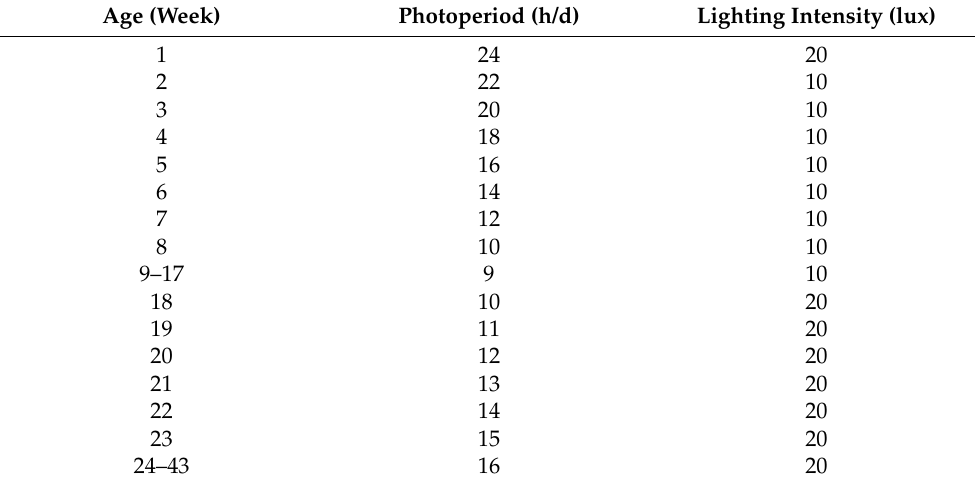
Table 2. Lighting program of Beijing-You chickens used in the present study. Age (Week) Photoperiod (h/d) Lighting Intensity